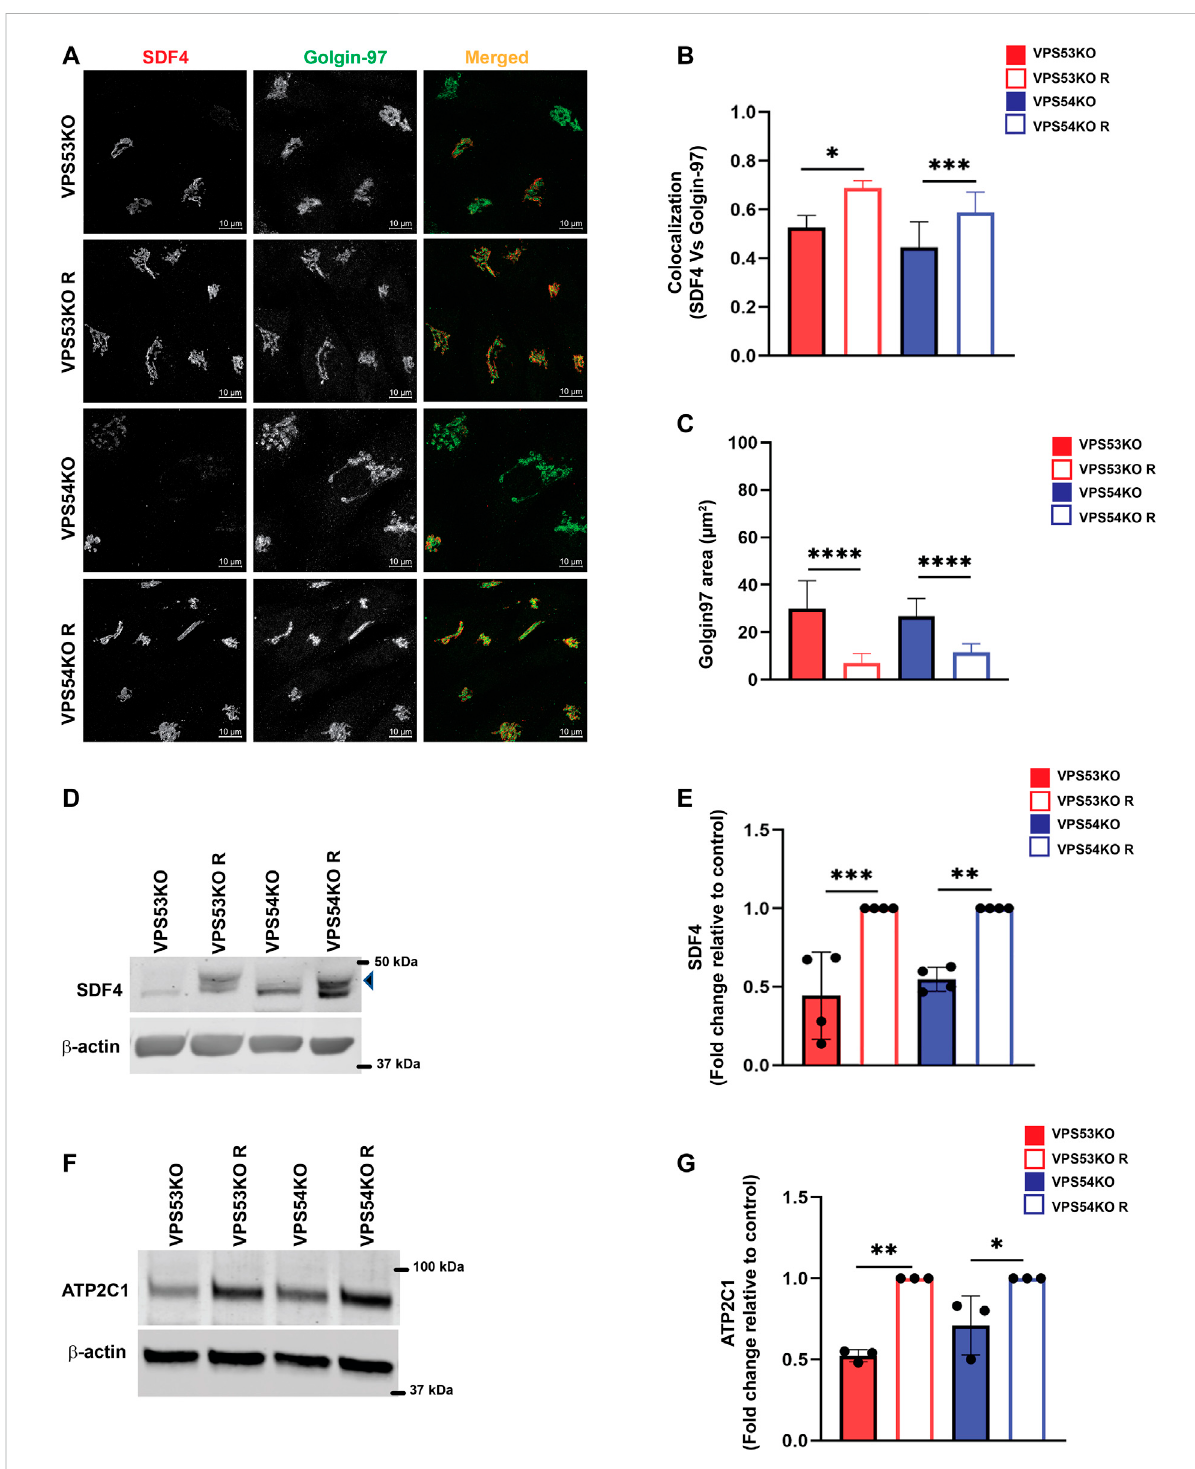
FIGURE 3 GARP dysfunction alters cellular expression of Ca 2+ binding SDF4/Cab-45 and Ca 2+ -transporting ATP2C1/SPCA1 Golgi proteins. (A) Airyscan microscopy of VPS53KO, VPS53KO R, VPS54KO and VPS54KO R cells co-stained for SDF4 and Golgin97. (B) The graph shows the quanti fi cation of SDF4 and Golgin97 colocalization using Pearson ’ s correlation coef fi cient. Values in the bar graph represent the mean ± SD from the colocalization between SDF4 and Golgin97 from 50 different cells. (C) Quanti fi cation of Golgin97 area. n = 30 cells per group. (D) WB analysis of SDF4 in GARP-KO and rescued cells. The arrowheadpointingtoSDF4isthespeci fi cband. (E) Quanti fi cationofSDF4WBsfromfourindependentexperiments. (F) WBanalysisofATP2C1inGARP-KOand rescuedcells. (G) Quanti fi cationofATP2C1blotsfromthreeindependentexperiments. β -actinwasusedastheinternalloadingcontrol.Valuesinbargraphrepresent themean± SDfrom atleastthree independentexperiments. Statistical signi fi cance wascalculatedusing one-way ANOVA. *** p ≤ 0.001, ** p ≤ 0.01, * p ≤ 0.05.